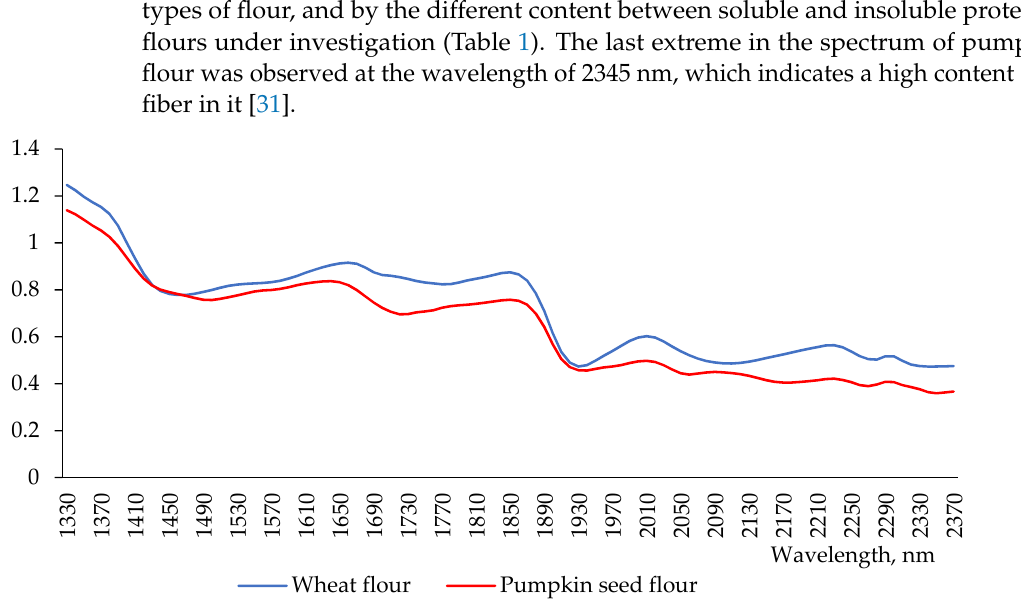
Figure 2. Spectra of reflection of wheat flour and pumpkin seed flour. After kneading the dough, the spectra of the obtained samples with different concentrations of pumpkin seed flour to replace part of the wheat flour differed slightly, even though all the extremes were identical (Figure 3). However, the spectrum of the control sample had a lower intensity of reflection than pumpkin seed flour ‐ addicted samples, and an evident pumpkin seed flour ‐ dependent intensity of reflection was observed in the other samples. At 1930 nm, the wavelength responsible for the moisture content in the product, the reflection intensity of all samples coincided. This could be due to the fact that the samples were dried. The similar nature of the obtained spectra indicated that the determining factor influencing the formation of the properties of the dough was wheat flour, since it was the mass fraction which remains the largest in the dough. However, during the formation of the dough, there were changes in the structural elements (in particular, the absorption of water by fiber contained in pumpkin seed flour) in dough with pumpkin seed flour when compared with control sample. For this reason, the intensity of the reflection of pumpkin seed flour, independently of the pumpkin seed flour percentage, tended to the spectrum of control dough, acquiring springy ‐ elastic and viscous ‐ plastic properties that are conferred in the control sample by the content of glutenins and gliadins of wheat flour.